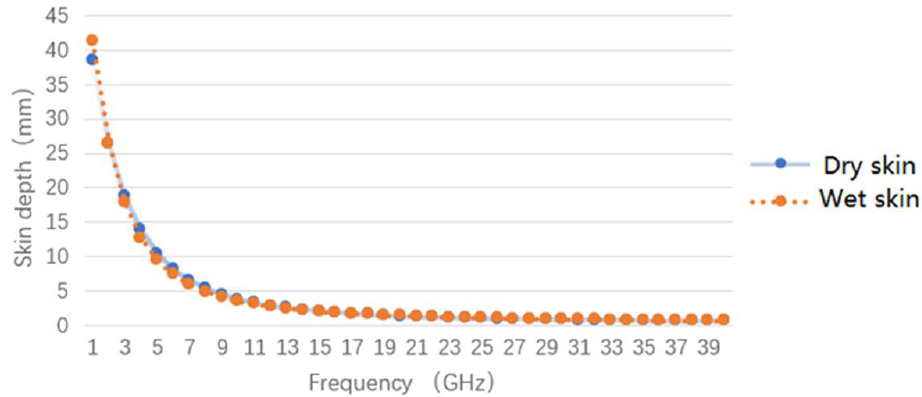
Figure 3. Relationship between skin depth and microwave frequency.